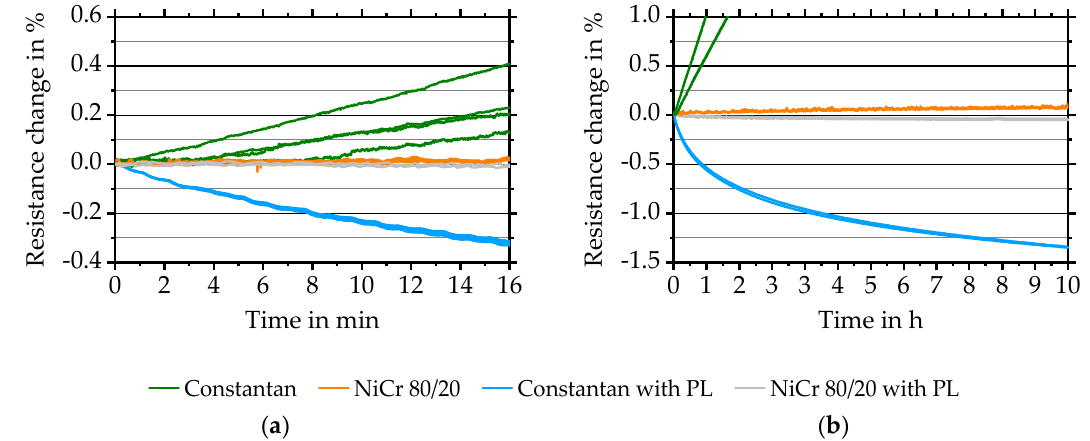
Figure 6. ( a ) The resistance change of Constantan and NiCr 80 / 20 quarter-bridges R1-R4 with protective layer (PL) compared to Constantan and NiCr 80 / 20 quarter-bridges without protective layer at 150 ◦ C. ( b ) Ten hours long-time behaviour of Constantan and NiCr 80 / 20 quarter-bridges, R1 and R2, with and without protective layer at 150 ◦ C.